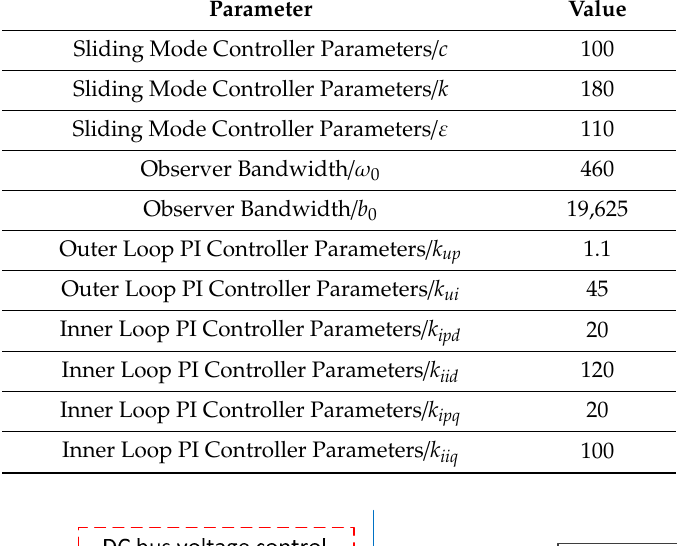
Table 2. Controller parameters.